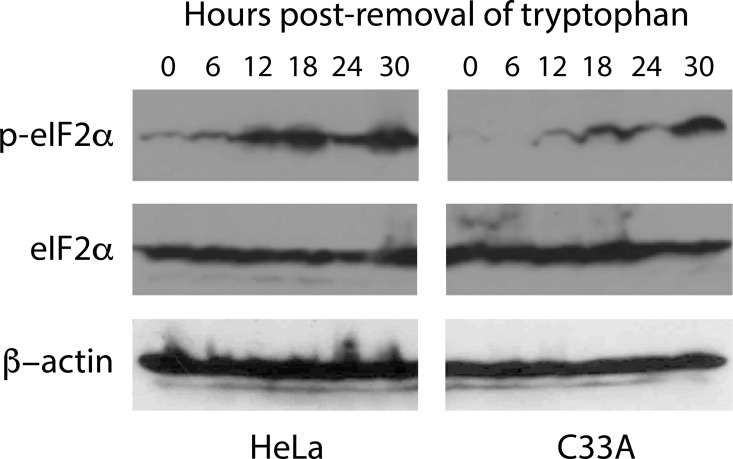
Temporal evaluation of eIF2α phosphorylation in HeLa and C33A grown in tryptophan-free media.HeLa and C33A cells were plated in complete media, which was replaced with tryptophan-free media 24 hours post-plating. Cells were harvested every 6 hours and used to make extracts that were evaluated by immunoblot using antibodies against eIF2α or eIF2α phosphorylated on serine 51 (p-eIF2α). Immunoblots against β-actin were performed as a loading control. Similar results were obtained from three independent experiments.